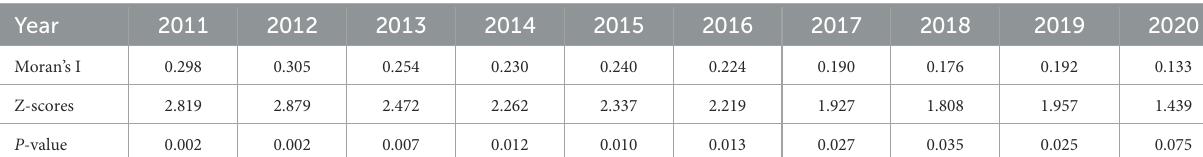
TABLE 4 Global Moran’s I index from 2011 to 2020.